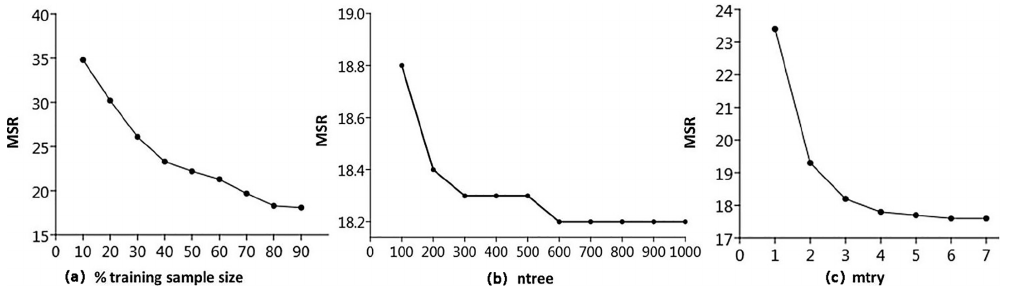
Figure 11. (a) The effect of training sample size in RF error (in MSR). (b) The effect of the ntree parameter in RF error (in MSR) for the